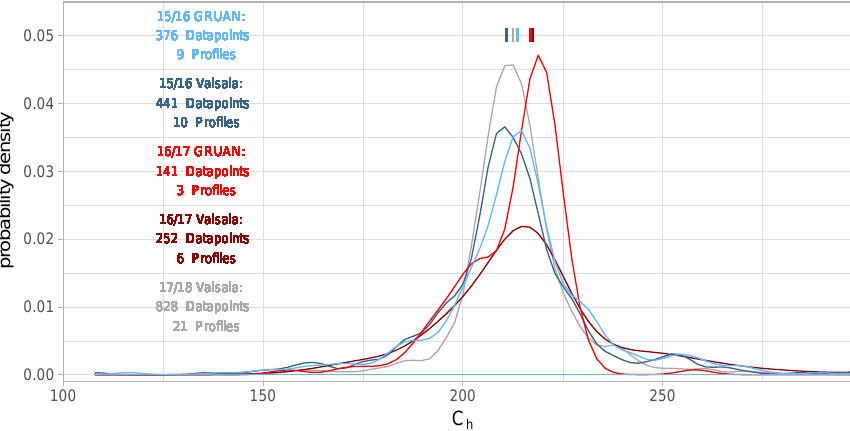
Figure 4. Probability density function of C i for different years and different radiosonde products as reference datasets. Respective median C indicated by an